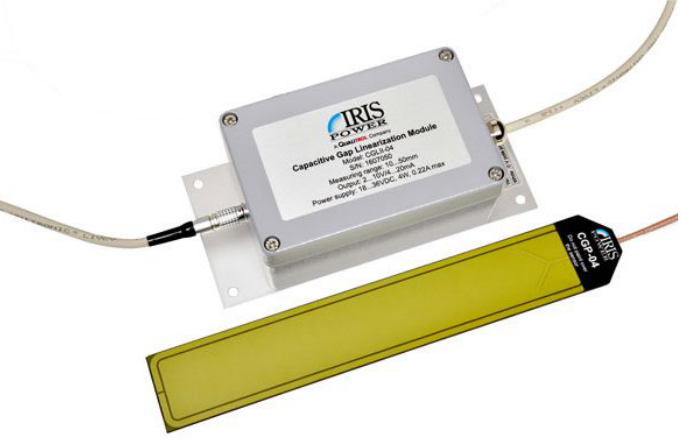
Figure 5. An example of a capacitive air gap sensor.